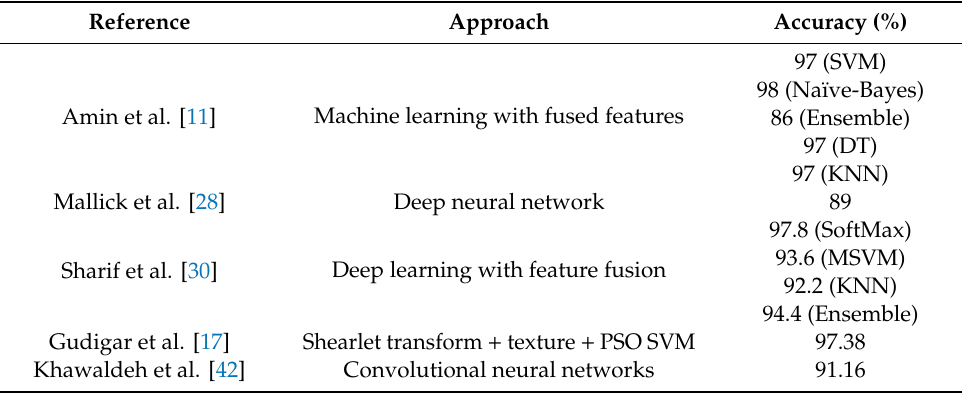
Table 5. Performance validation of proposed VGG19 with the existing